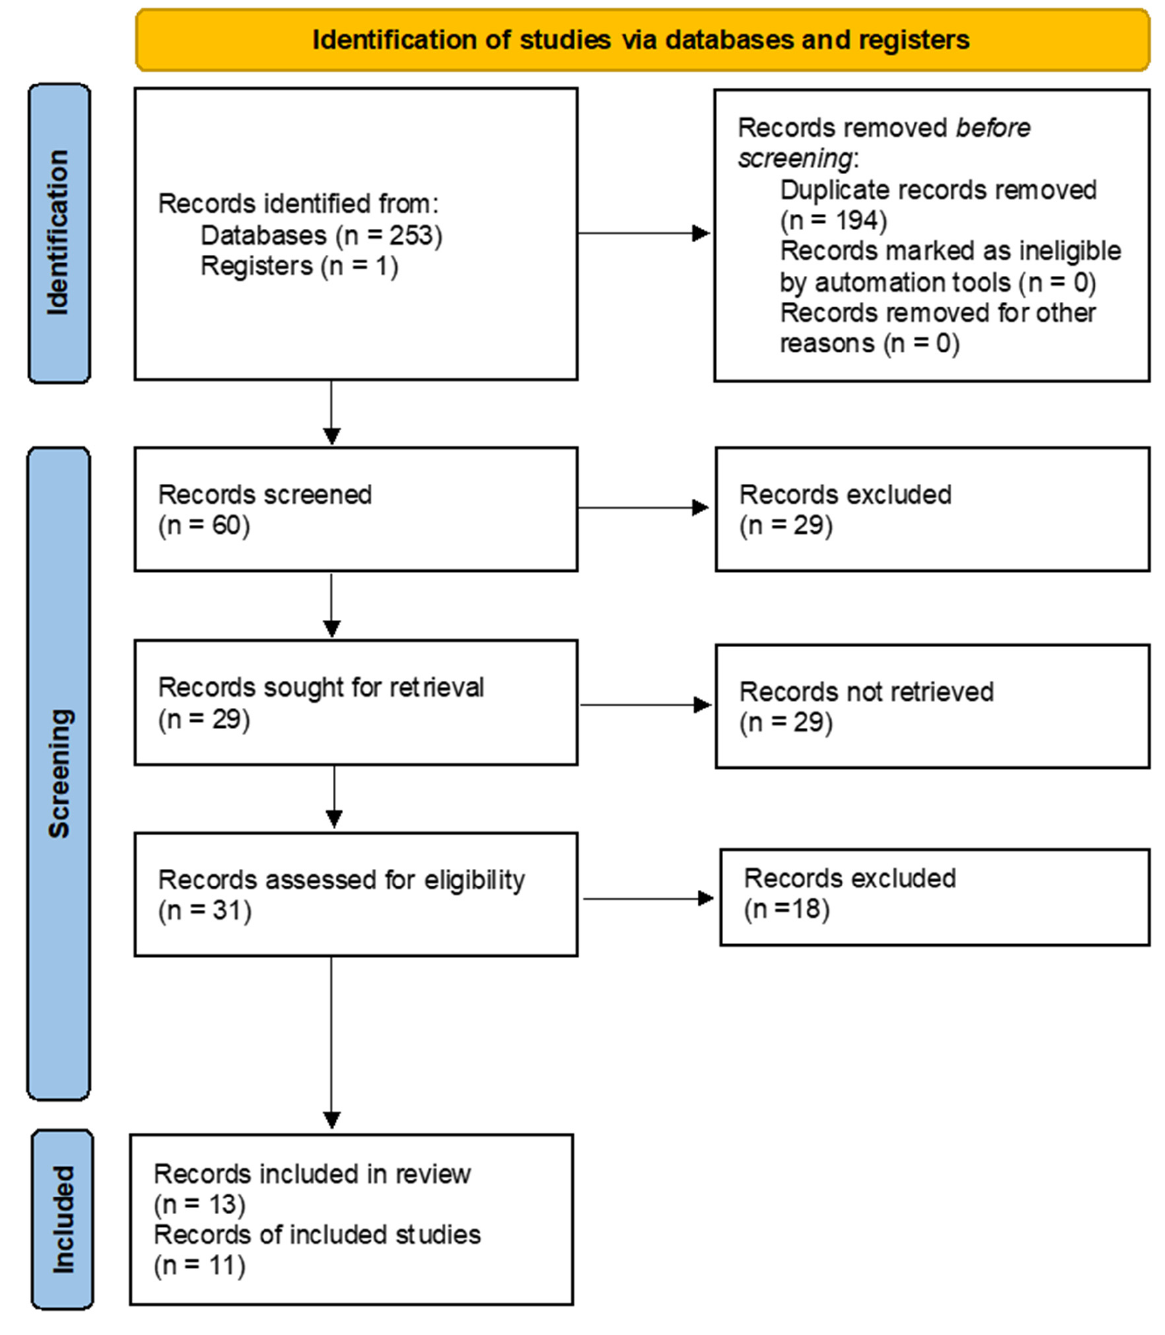
Figure 2. Flow diagram of the present systematic review and meta-analysis following PRISMA guidelines.